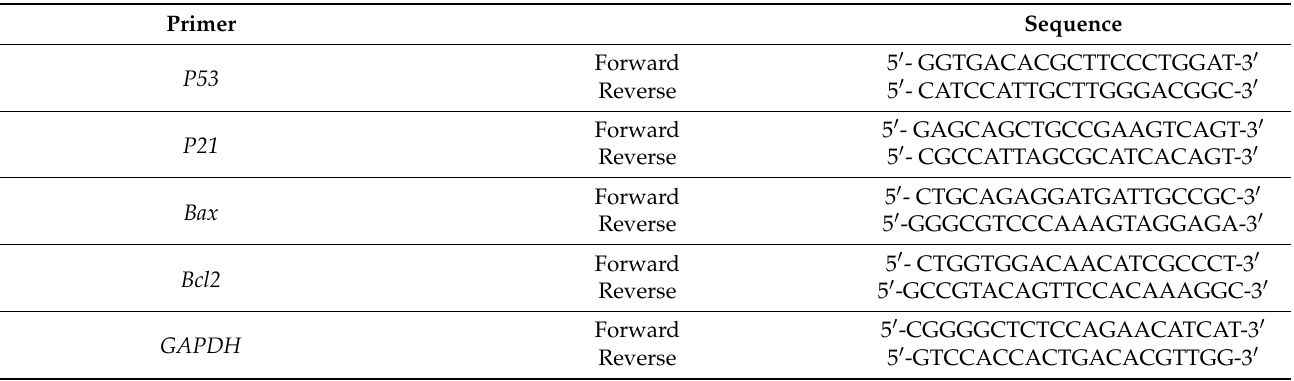
Table 2. Sequences of